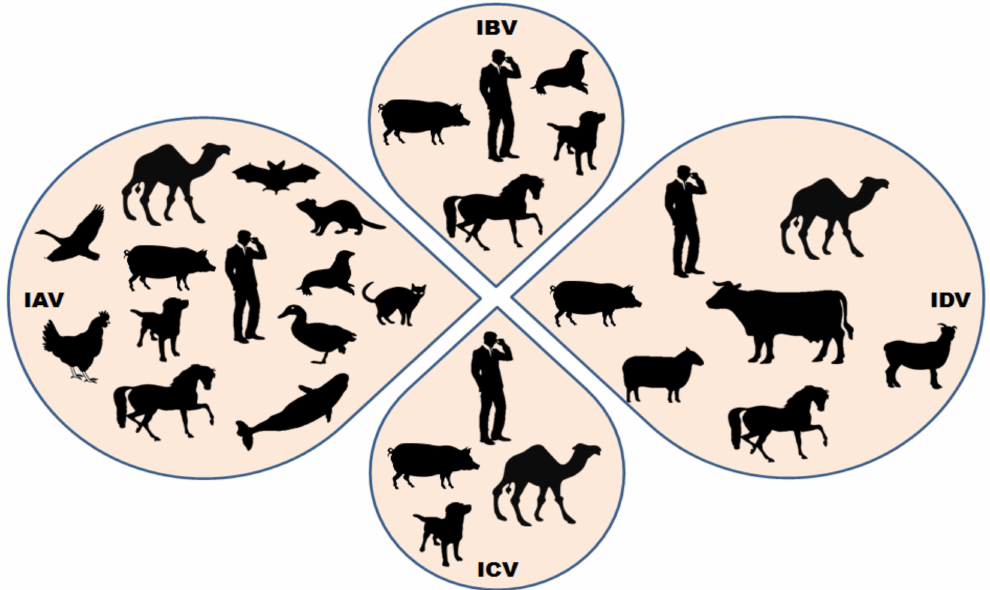
Figure 1. Summary of the wide host range of influenza viruses. Few host species are susceptible to infection by all the four known influenza viruses (influenza A virus—IAV, influenza B virus—IBV, influenza C virus—ICV and influenza D virus—IDV), while others are known to be infected by only specific influenza viruses. Cattles are the major known reservoir of influenza D virus; however, other small ruminants and humans have shown susceptibility to IDV infections in different